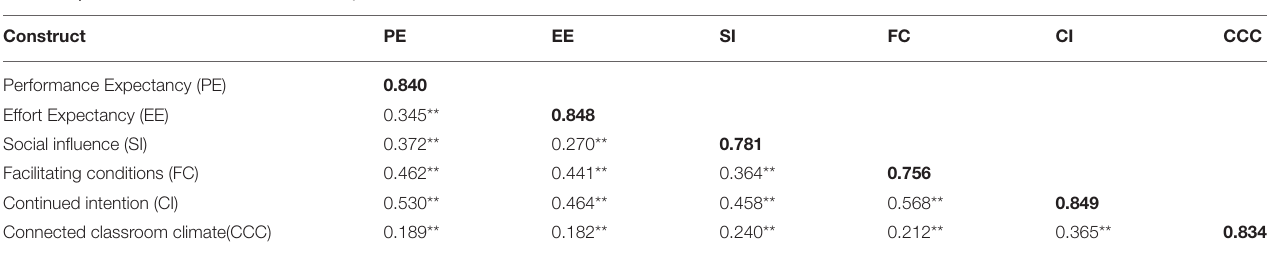
TABLE 5 | Correlations and discriminant validity of the UTAUT